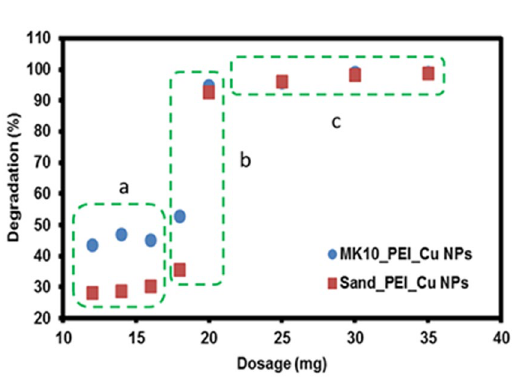
Figure 5. Influence of catalyst dosage on degradation of atrazine. (Conditions: atrazine = 20 mg L − 1 , volume of solution = 20 mL, H 2 O 2 (30%) = 20 μ L); dotted boxes mark different zones of catalyst